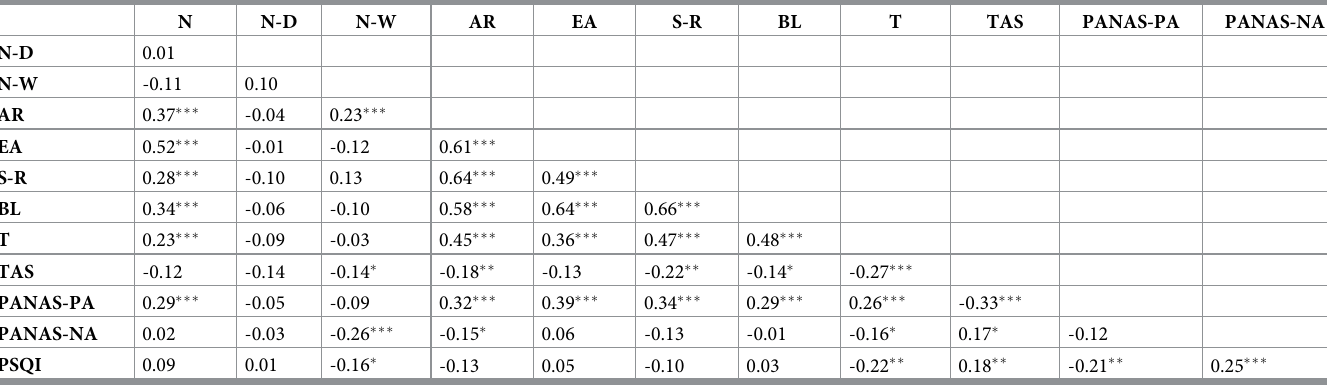
Table 3. Partial correlation of modelled variables (controlling for social desirability).